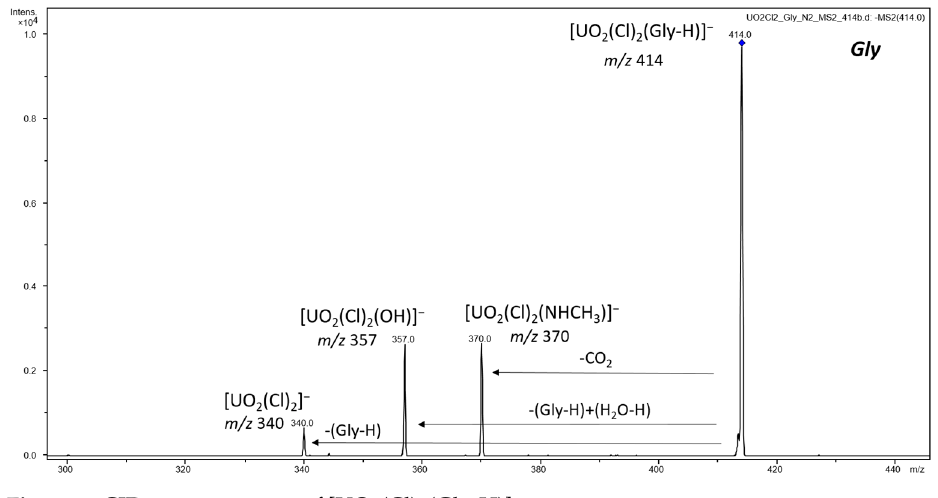
Figure 7. CID mass spectrum of [UO 2 (Cl) 2 (Gly-H)] − .